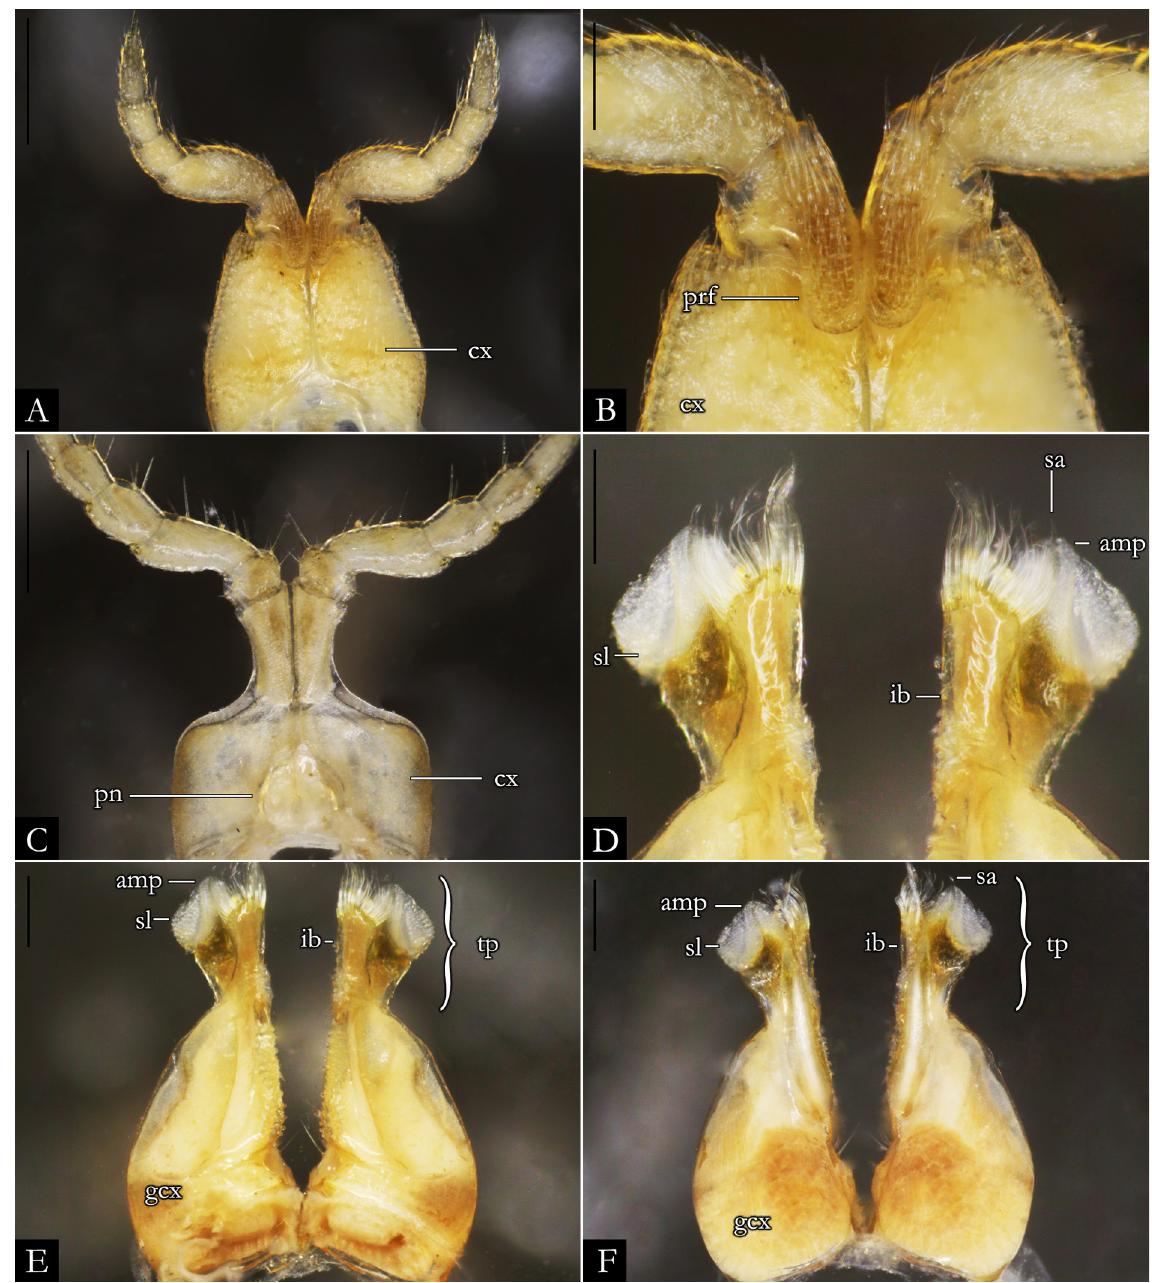
Fig. 86. Pseudonannolene lundi Iniesta & Ferreira, 2015, paratype, ♂ (ISLA 8685). A . First leg-pair. B . Detail of prefemur. C . Second leg-pair. D . Detail of telopodites, in anal view. E . Gonopods, in anal view. F . Gonopods, in oral view. Abbreviations: see Material and methods. Scale bars: A, C, E–F = 0.5 mm; B, D = 0.2